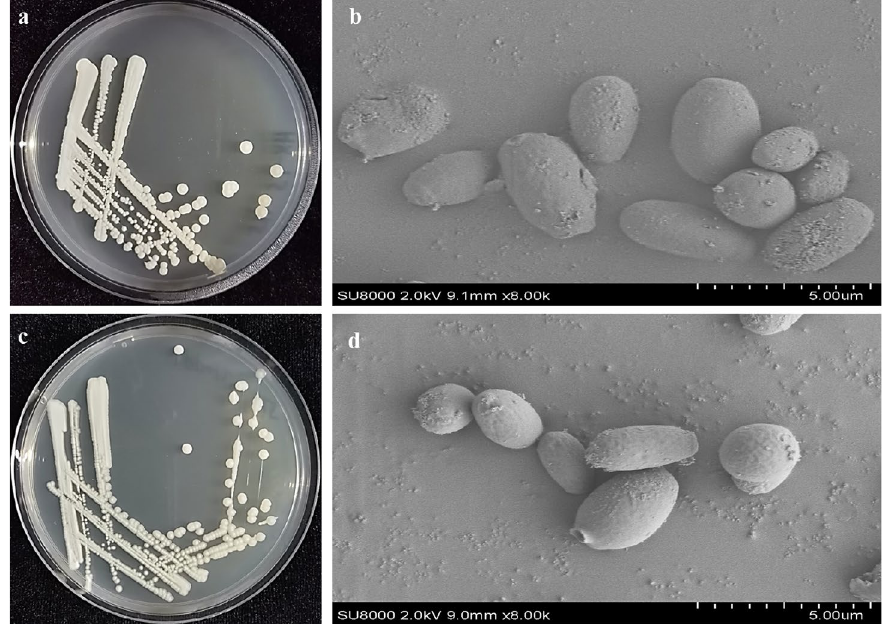
Figure 2. Colony morphology [( a ) HX-YS; ( c ) LPP-12 Y] and SEM micrographs [( b ) HX- YS; ( d ) LPP-12Y] (SEM at 2.0 kV and